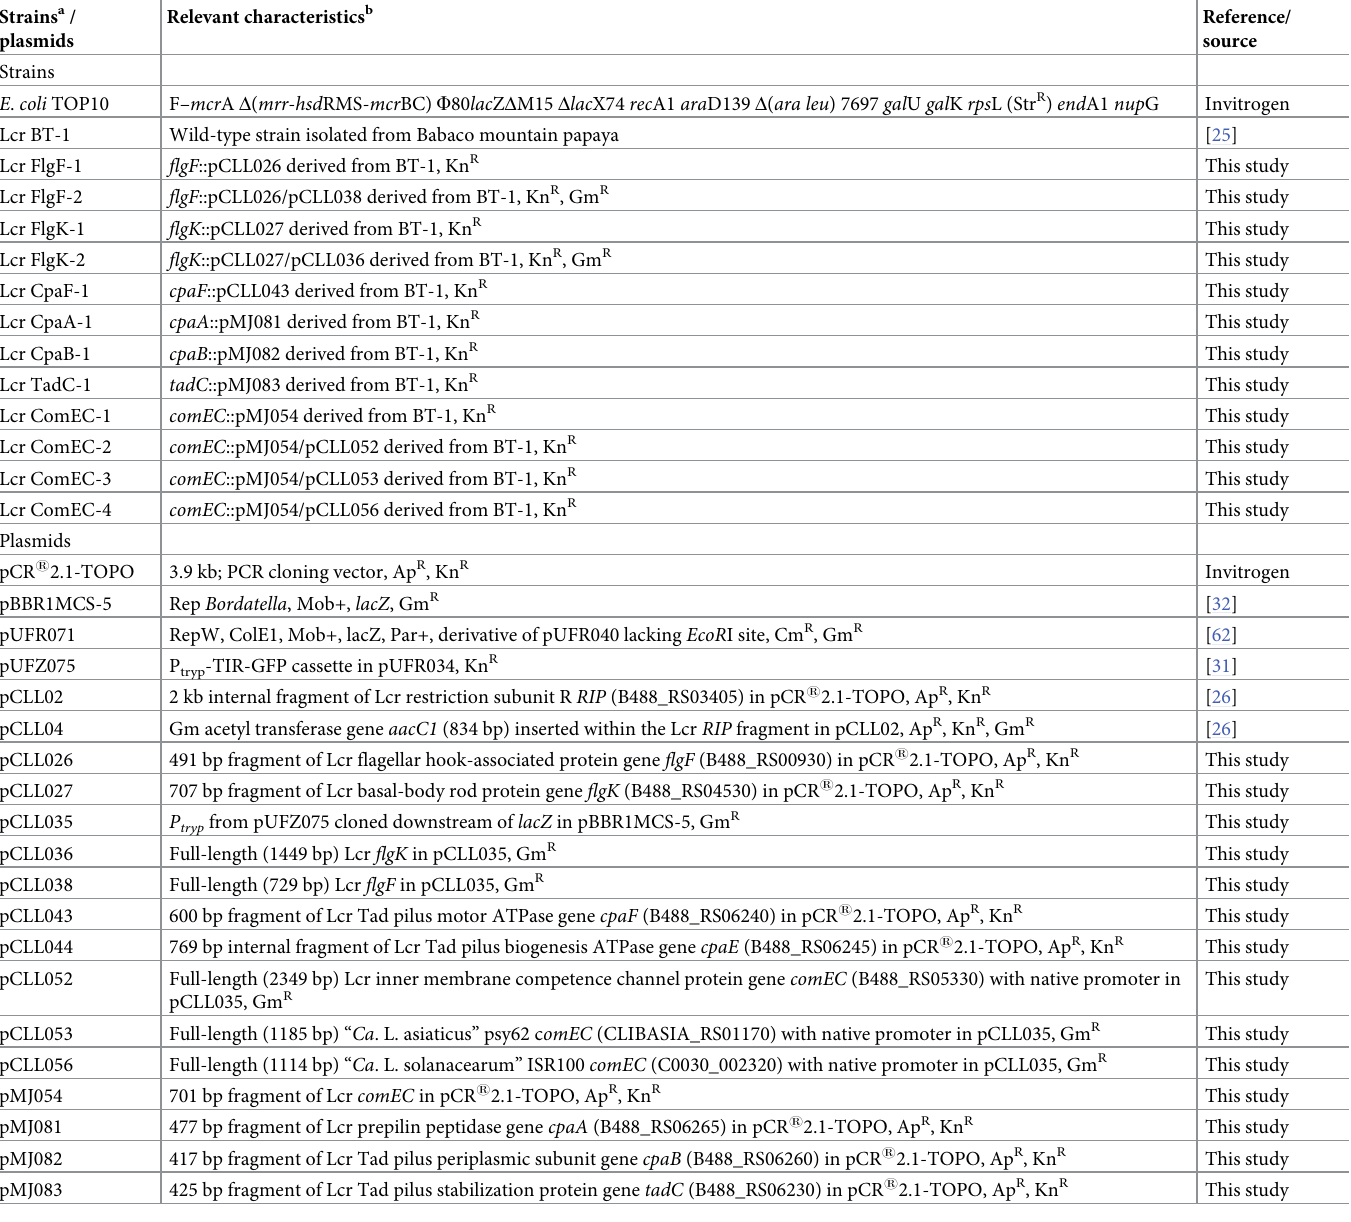
Table 1. Bacterial strains and plasmids used in this study. Relevant characteristics b Reference/ Strains a / plasmids